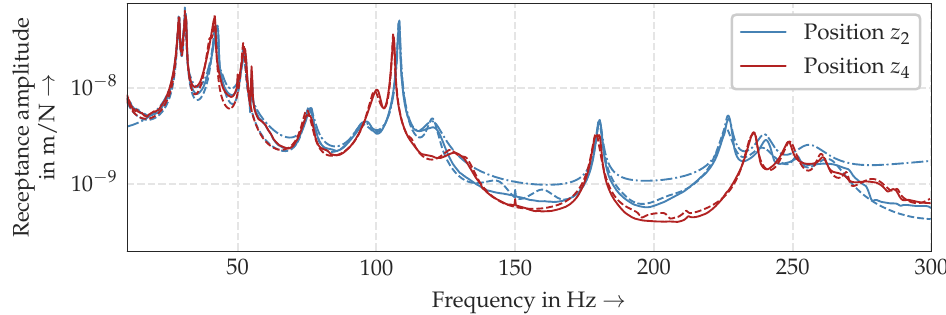
Figure 9. Comparison of the mean receptance amplitude of the original input FRFs (solid) with the fitted FRFs from the modal model (MATLAB ® : dash-dotted, AutoEMA: dashed); the comparison is shown for the WPT positions having the lowest number of found modes z 2 and the one at the greatest distance, that is, position z 4 . Due to the high calculation times, MATLAB ® results are only available for position z 2 .